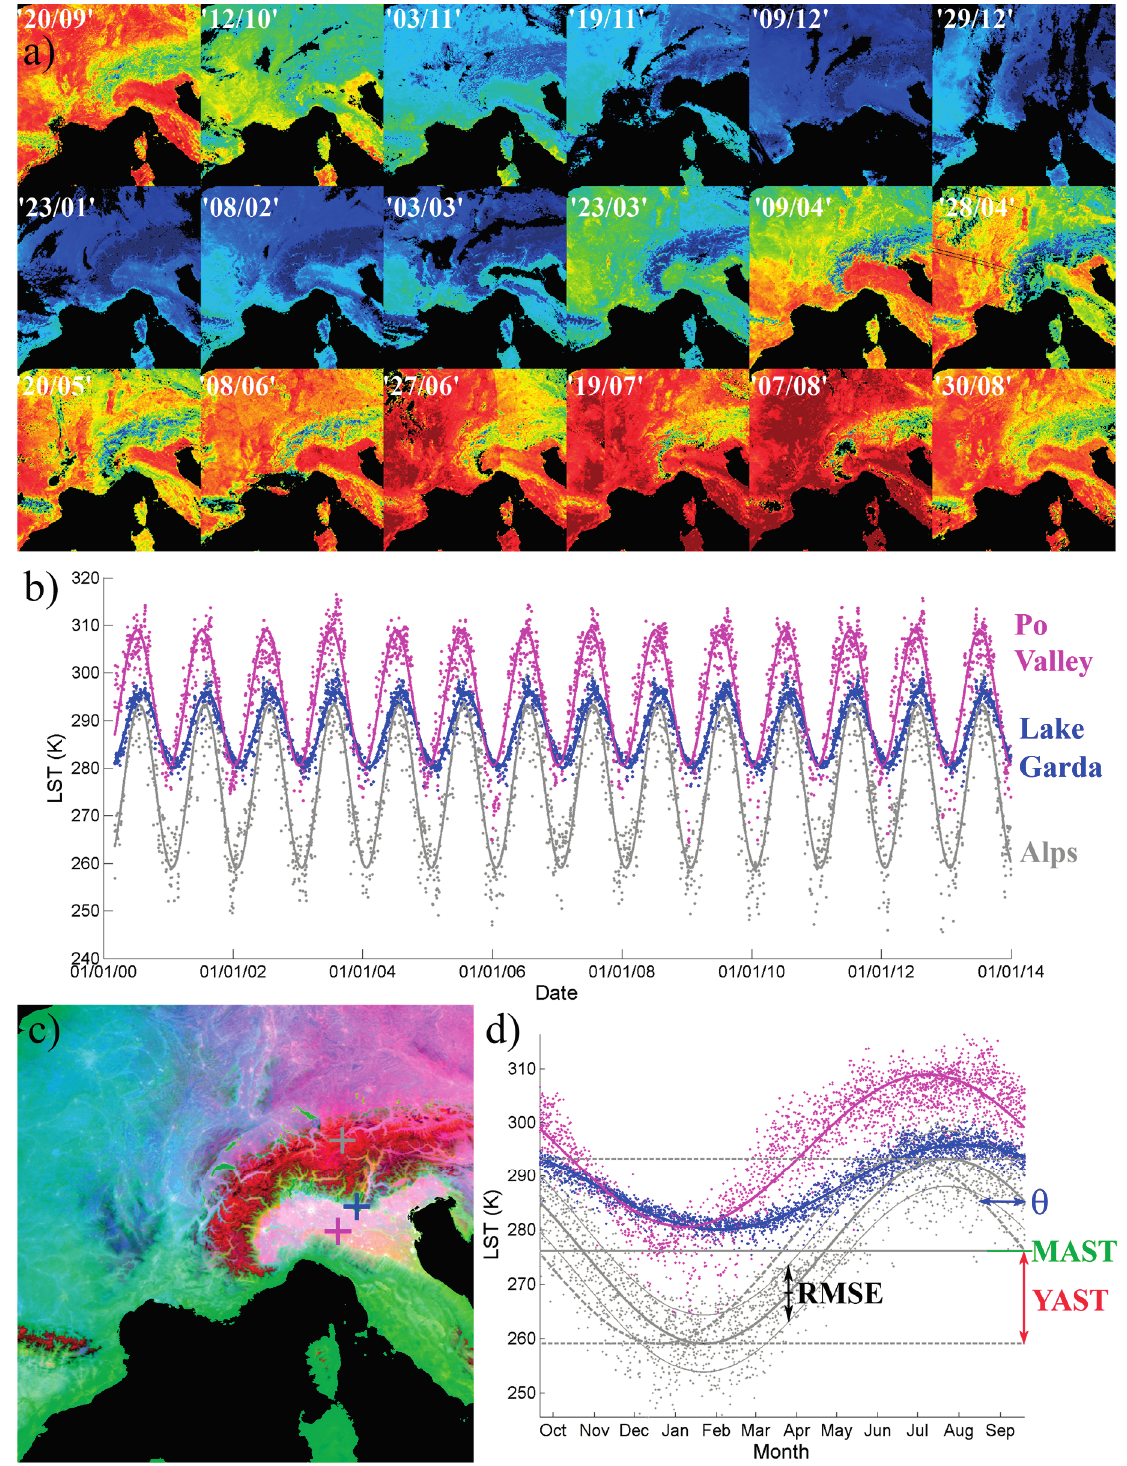
Figure 2. Principle of the annual cycle parameters. ( a ) Sequence of acquisitions from tile h18v04 (covering Northern Italy, Switzerland, as well as large parts of France and Southern Germany) from different seasons (and also years); ( b ) Full time series for three selected pixels with different annual LST characteristics (Po Valley, Lake Garda, and Alpine mountains). ( c ) RGB color composite from the fitted parameters YAST, MAST and phase shift θ . Selected pixels are marked with +; ( d ) Annual cycle of the selected pixels and explanation of the parameters YAST, MAST, θ , and RMSE for the Alpine